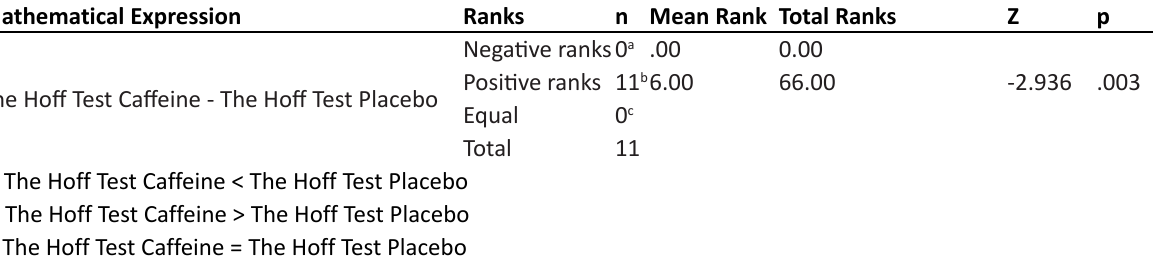
Table 6: Wilcoxon Signed Rank Analysis Results of Placebo Application (Sprint Test) Mathematical Expression